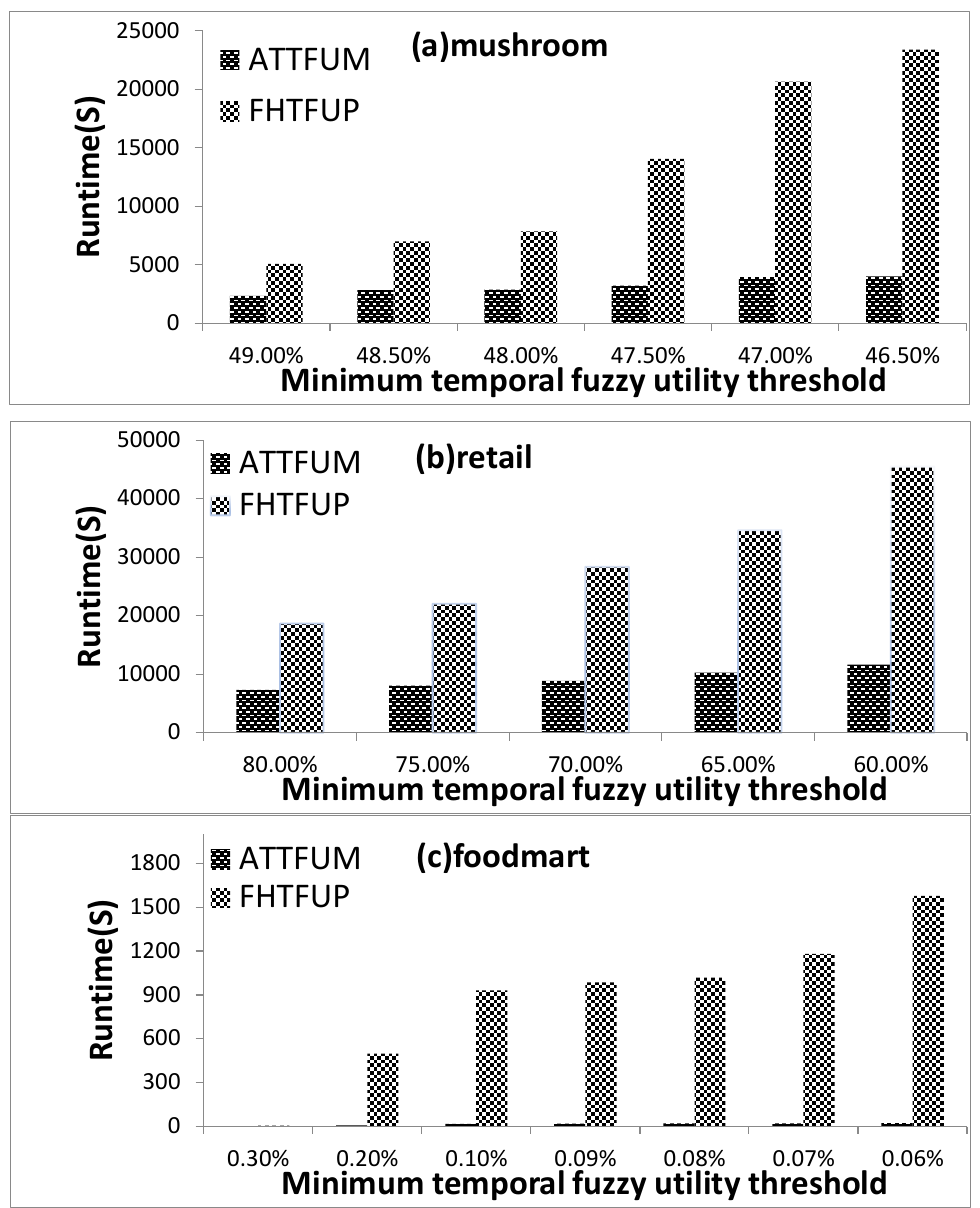
Figure 6. The comparison of running time for the two methods with different thresholds.